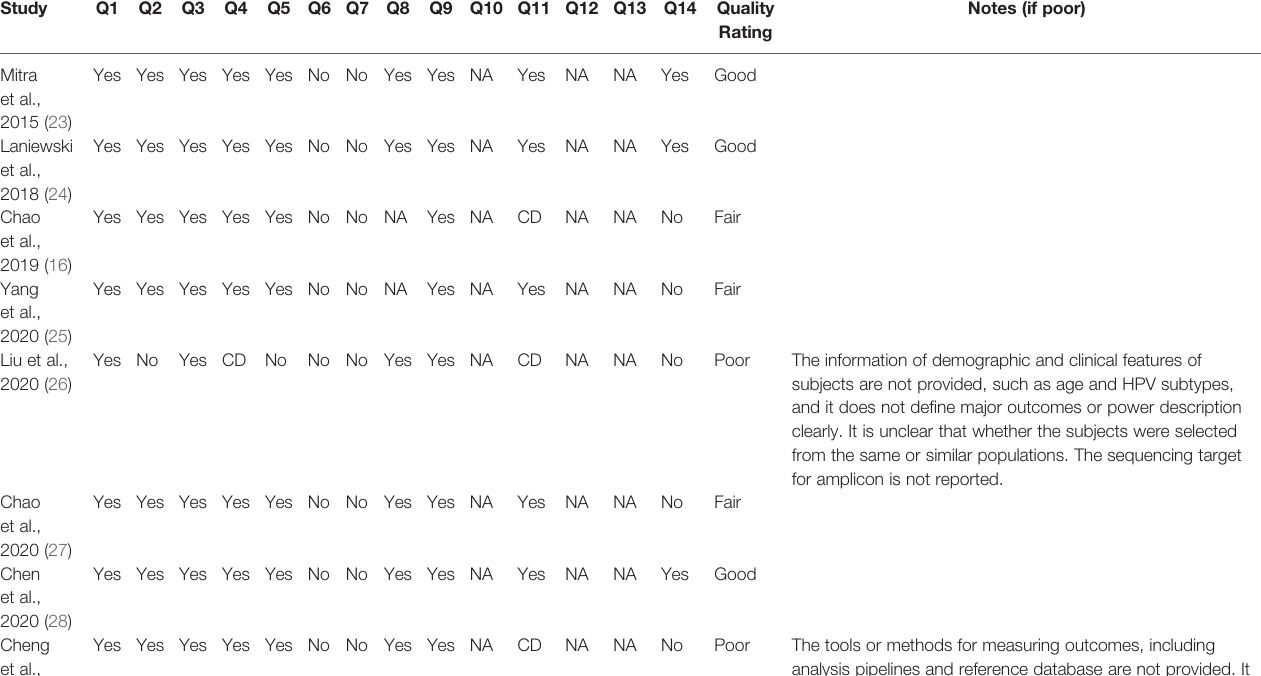
TABLE 4 | Quality assessment of included studies using the Quality Assessment Tool for Observational Cohort and Cross-Sectional Studies.